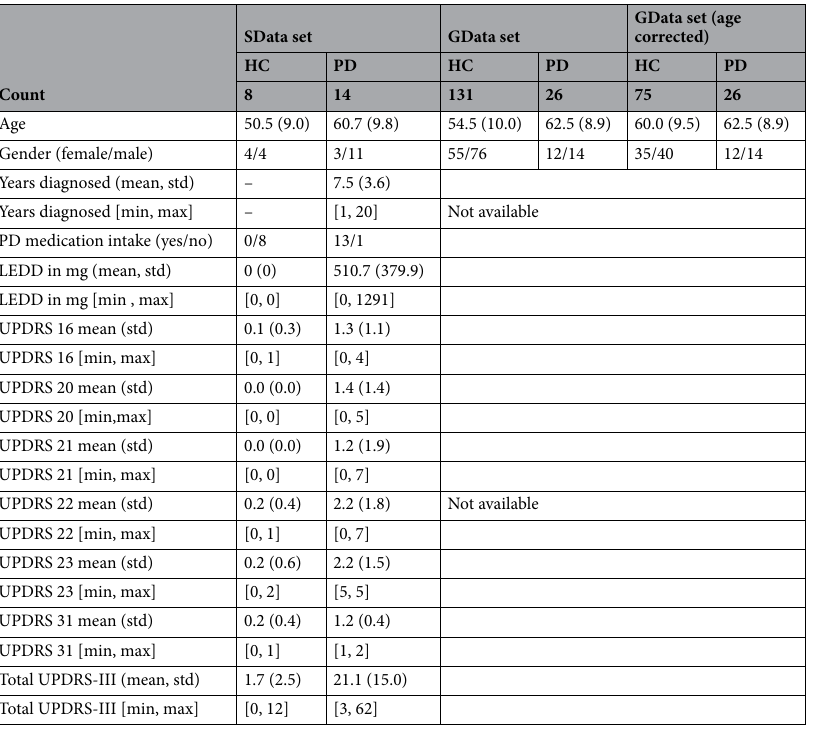
Table 1. Demographics and symptom information for the PD patient (PD) and Healthy Control (HC) populations of the two datasets (SData and GData) used in our experiments. Reported symptom scores include UPDRS items 16 (tremor self-report), 20 (hand rest tremor), 21 (hand action tremor), 22 (hand rigidity), 23 (finger tapping) and 31 (body bradykinesia), as well as the sum of all UPDRS part-III items. Scores for UPDRS 20–23 refer to the sum of both hand scores. UPDRS scores are not available for the GData set, as the GData subjects did not undergo a medical examination. The age corrected GData column contains the demographics of a typical random GData subset, sampled in such a way that the mean age of the HC population lies within ± 2.5 years of the mean age of the PD population (note: the maximum value of 12 in the total UPDRS-III score in the Healthy Control population is caused by a subject that exhibits arthrosis and other problems unrelated to PD.) LEDD stands for Levodopa Equivalent Daily Dose.